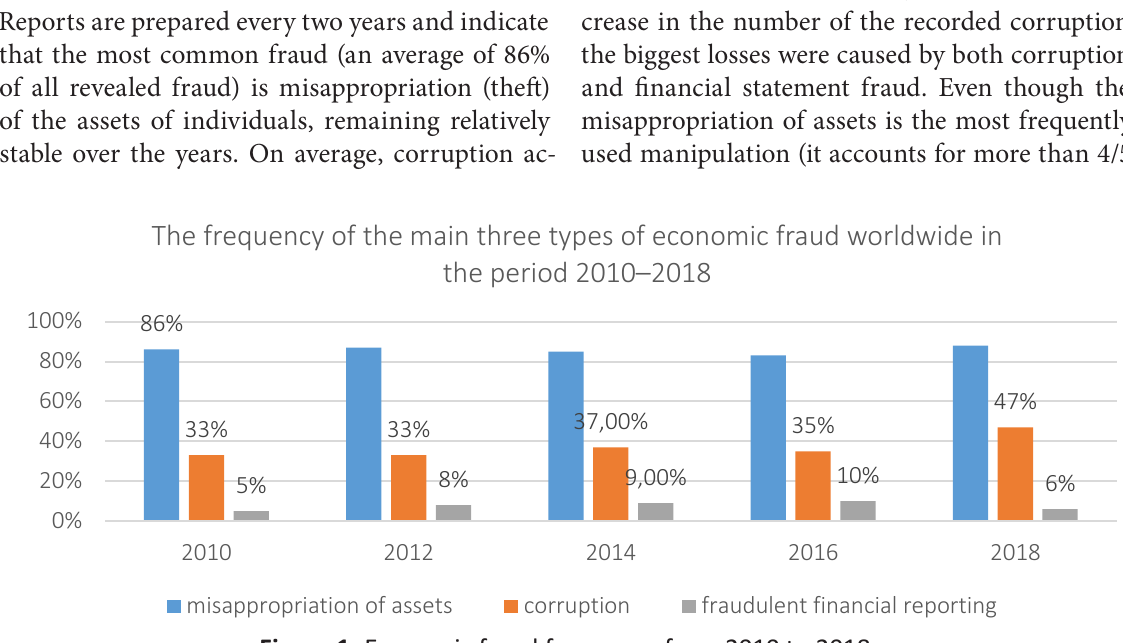
Figure 1. Economic fraud frequency from 2010 to